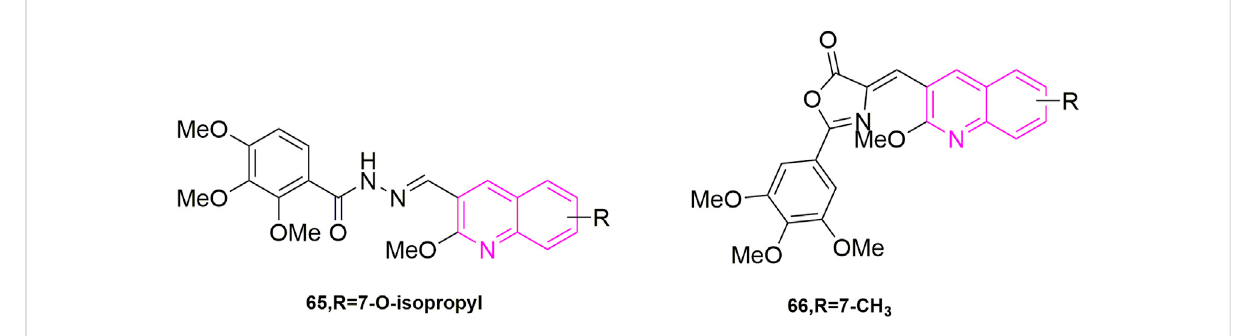
The structures of the compounds designed by Ibrahim et al. (2020,